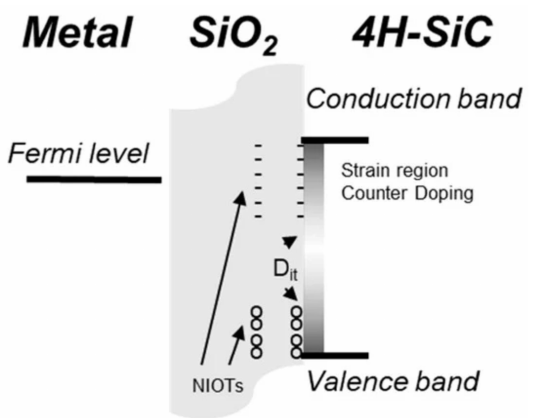
Figure 11. Graphical representation of the location of oxide traps and interface traps present at the interface of SiO2/4H-SiC